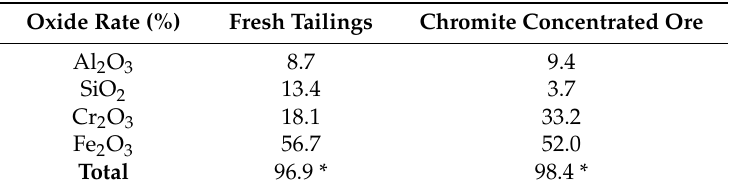
Table 1. XRF results of the fresh tailing and chromite concentrated ore sample collected in the beneficiation plant (Sukinda valley) in May 2017.